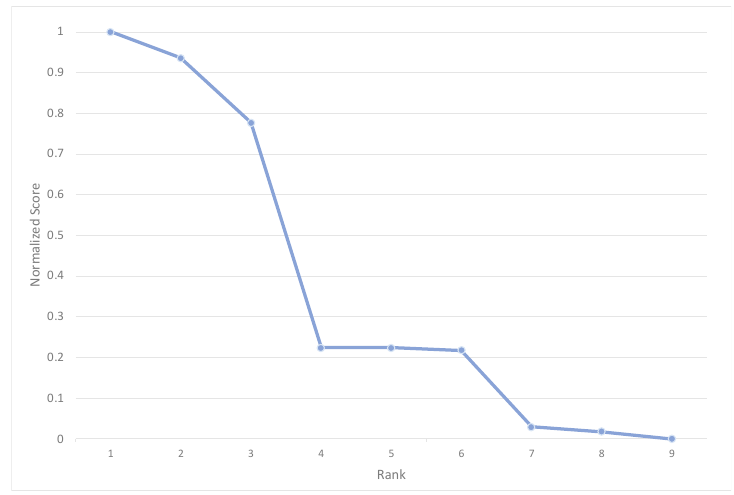
Figure 4. Rank-score functions of the cognitive diversity of the 9 test cases [30].